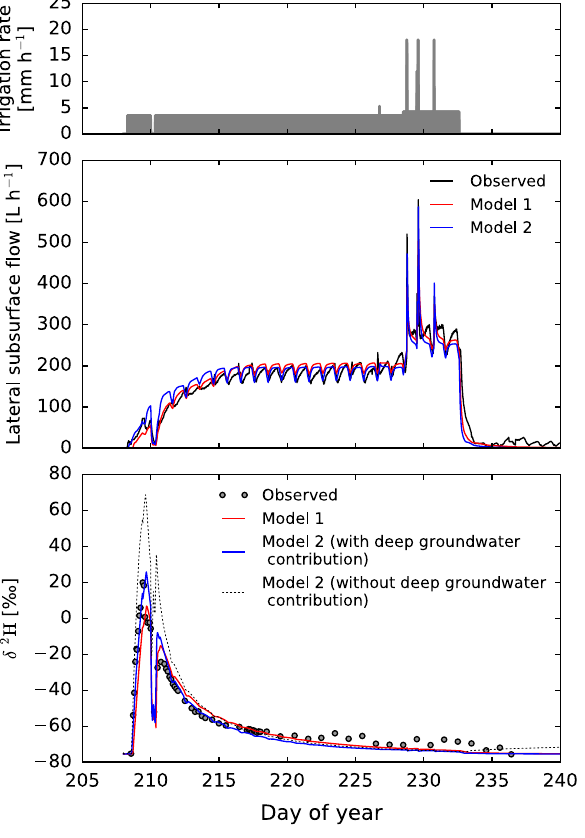
Figure 3. Observed (at the trench) and simulated lateral subsurface flow and δ 2 H breakthrough in lateral subsurface flow for Models 1 and 2.